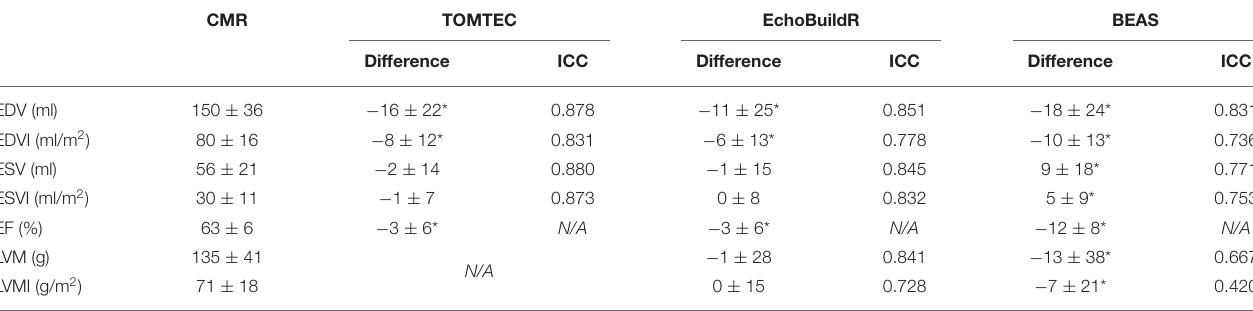
TABLE 1 | Differences in global LV indices (3D-echo–CMR, presented as mean ± SD) across 70 subjects for each 3D-echo segmentation tool compared to CMR-derived values with corresponding intraclass correlation coefficients (ICC).